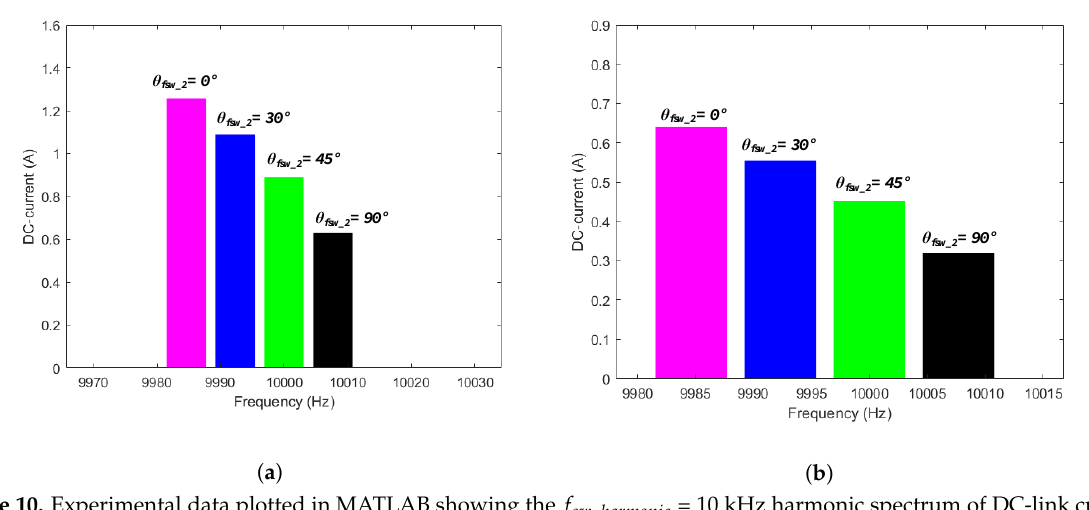
Figure 10. Experimental data plotted in MATLAB showing the f sw _ harmonic = 10 kHz harmonic spectrum of DC-link current for various θ fsw _2 for the multi-converter system with: ( a ) a common DC-bank, ( b ) individual DC-banks—both under scaled down operating conditions, given in Table 6.